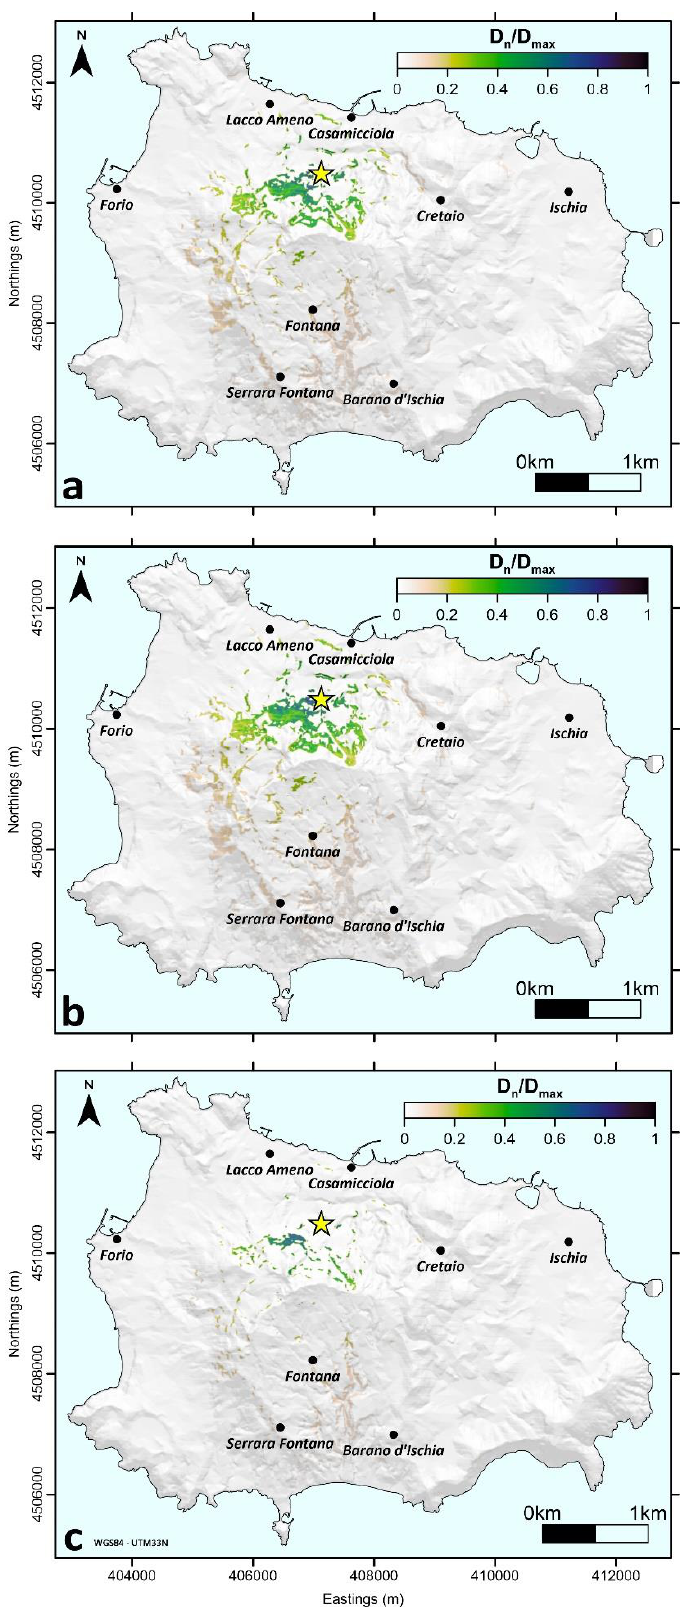
Figure 8. Estimated normalized Newmark displacements after being ( a ) halved the soil thickness; ( b ) decreased the PGA values; and ( c ) increased the strength parameters. The yellow star identifies the Ischia earthquake epicenter.